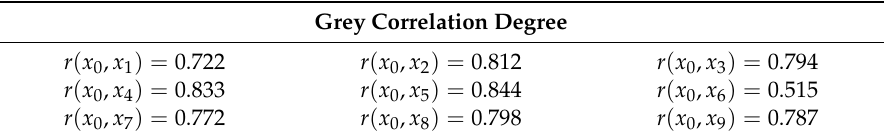
Table 4. The numerical values of r ( x 0 , x i ) .